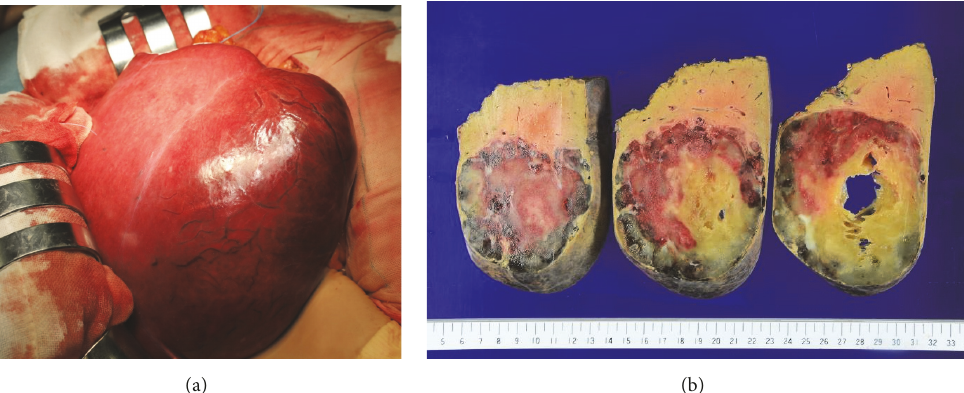
Figure 3: Intraoperativefindings and macroscopic findings of the resected tumor. Exploration of the abdominal cavity showed a relatively soft, dark red tumor (a). The cut surface demonstrated a white solid and cystic mass (170 × 100 × 80 mm in size) that was elastic, soft, and homogeneous with multiple hemorrhagic foci